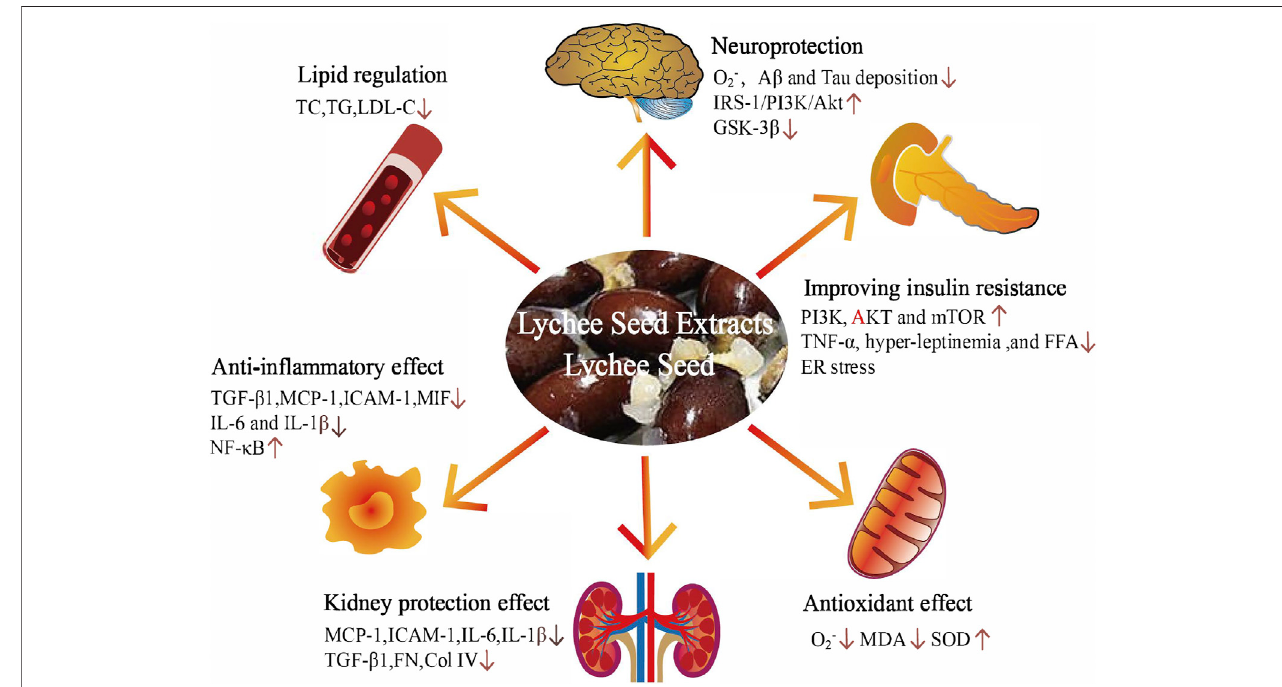
FIGURE 2 | The underlying mechanism of hypoglycemic activity of lychee seed and lychee seed extracts. Amyloid beta (A β ); tumor necrosis factor- α (TNF- α ); free fatty acids (FFAs); endoplasmic reticulum (ER); malondialdehyde (MDA); superoxide dismutase (SOD); monocyte chemotactic protein 1 (MCP-1); intercellular cell adhesion molecule-1 (ICAM-1); interleukin-6 (IL-6); interleukin-1 (IL-1 β ); transforming growth factor- β 1 (TGF- β 1); fi bronectin (FN); collagen IV (Col IV); macrophage migration-inhibitory factor (MIF); nuclear factor- κ B (NF- κ B); cholesterol (TC); triglyceride (TG); and low-density lipoprotein cholesterol (LDL-C).